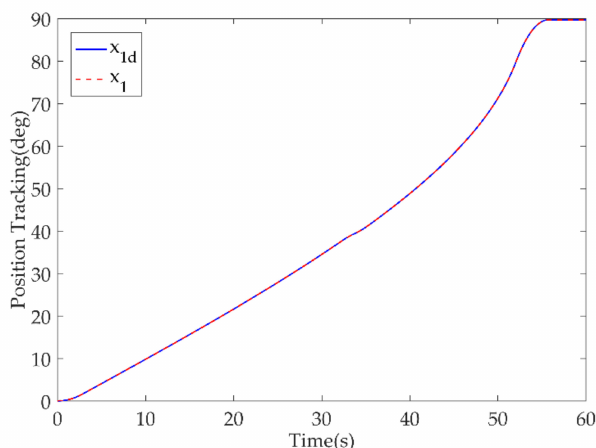
Figure 10. Tracking performance under RISE-NN-TAS controller in case 1.